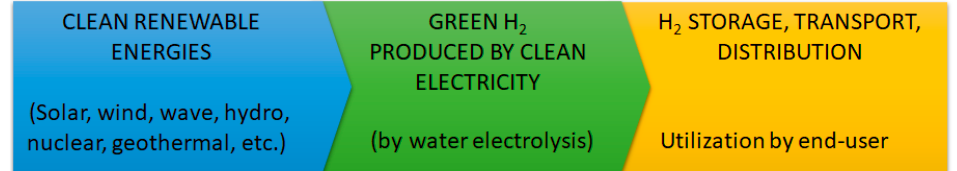
Figure 2. Integrated RE H 2 system and economy. Figure 1. Comparison of specific energy (energy per mass or gravimetric density) and energy den- sity (energy per volume or volumetric density) for several fuels based on lower heating values. After [14].